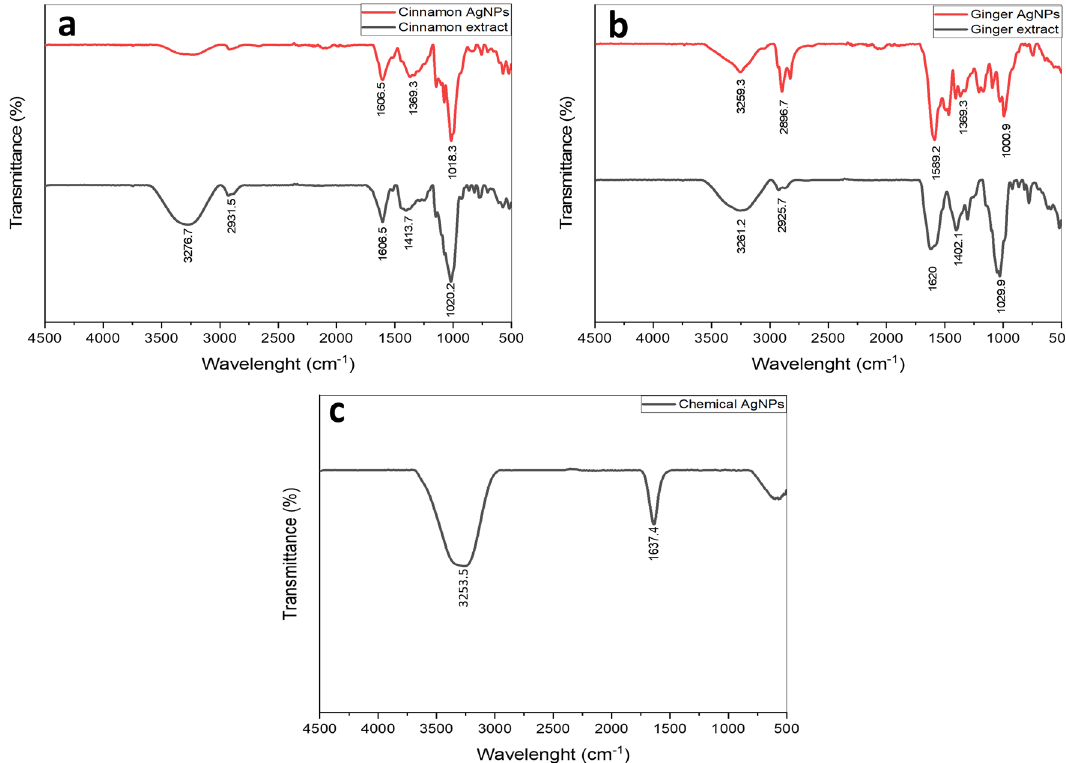
Figure 4. FTIR spectra of ( a ) cinnamon extract (black) and cinnamon AgNPs (red), ( b ) ginger extract (black) and ginger AgNPs (red), and ( c ) chemical